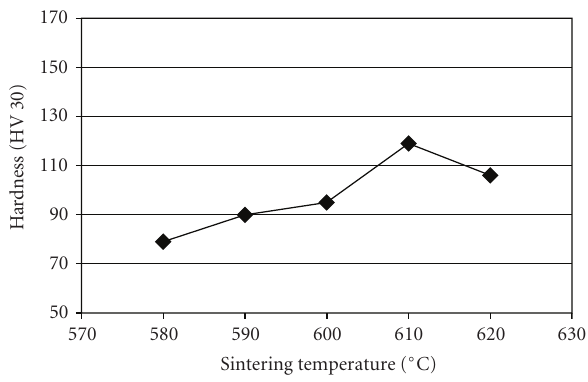
Figure 6: E ff ect of sintering temperature on macrohardness of sintered Alumix